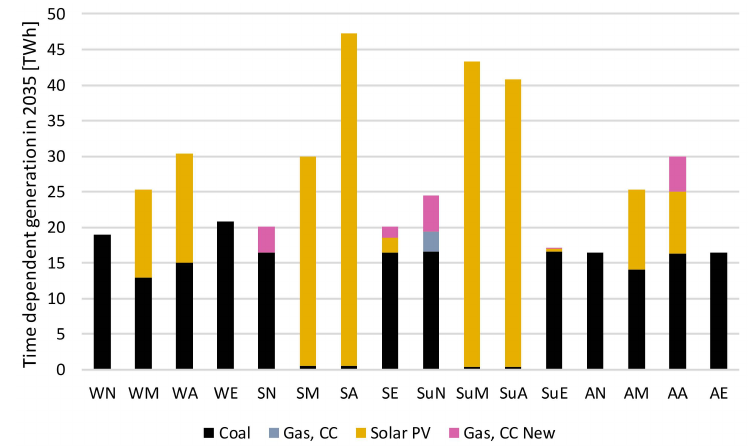
Figure 12. Generation (TWh) per time slice in 2035 in the RETarget scenario—with code